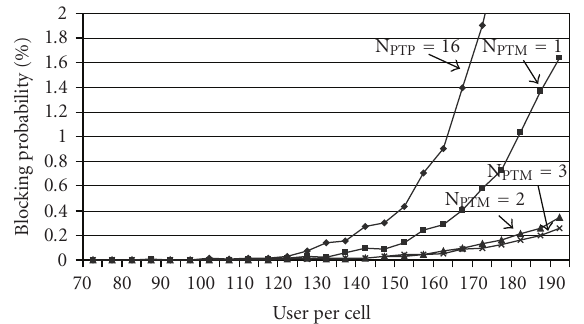
Figure 15: Blocking probability over user density for delivery of 20 TV channels over MBMS in a UMTS